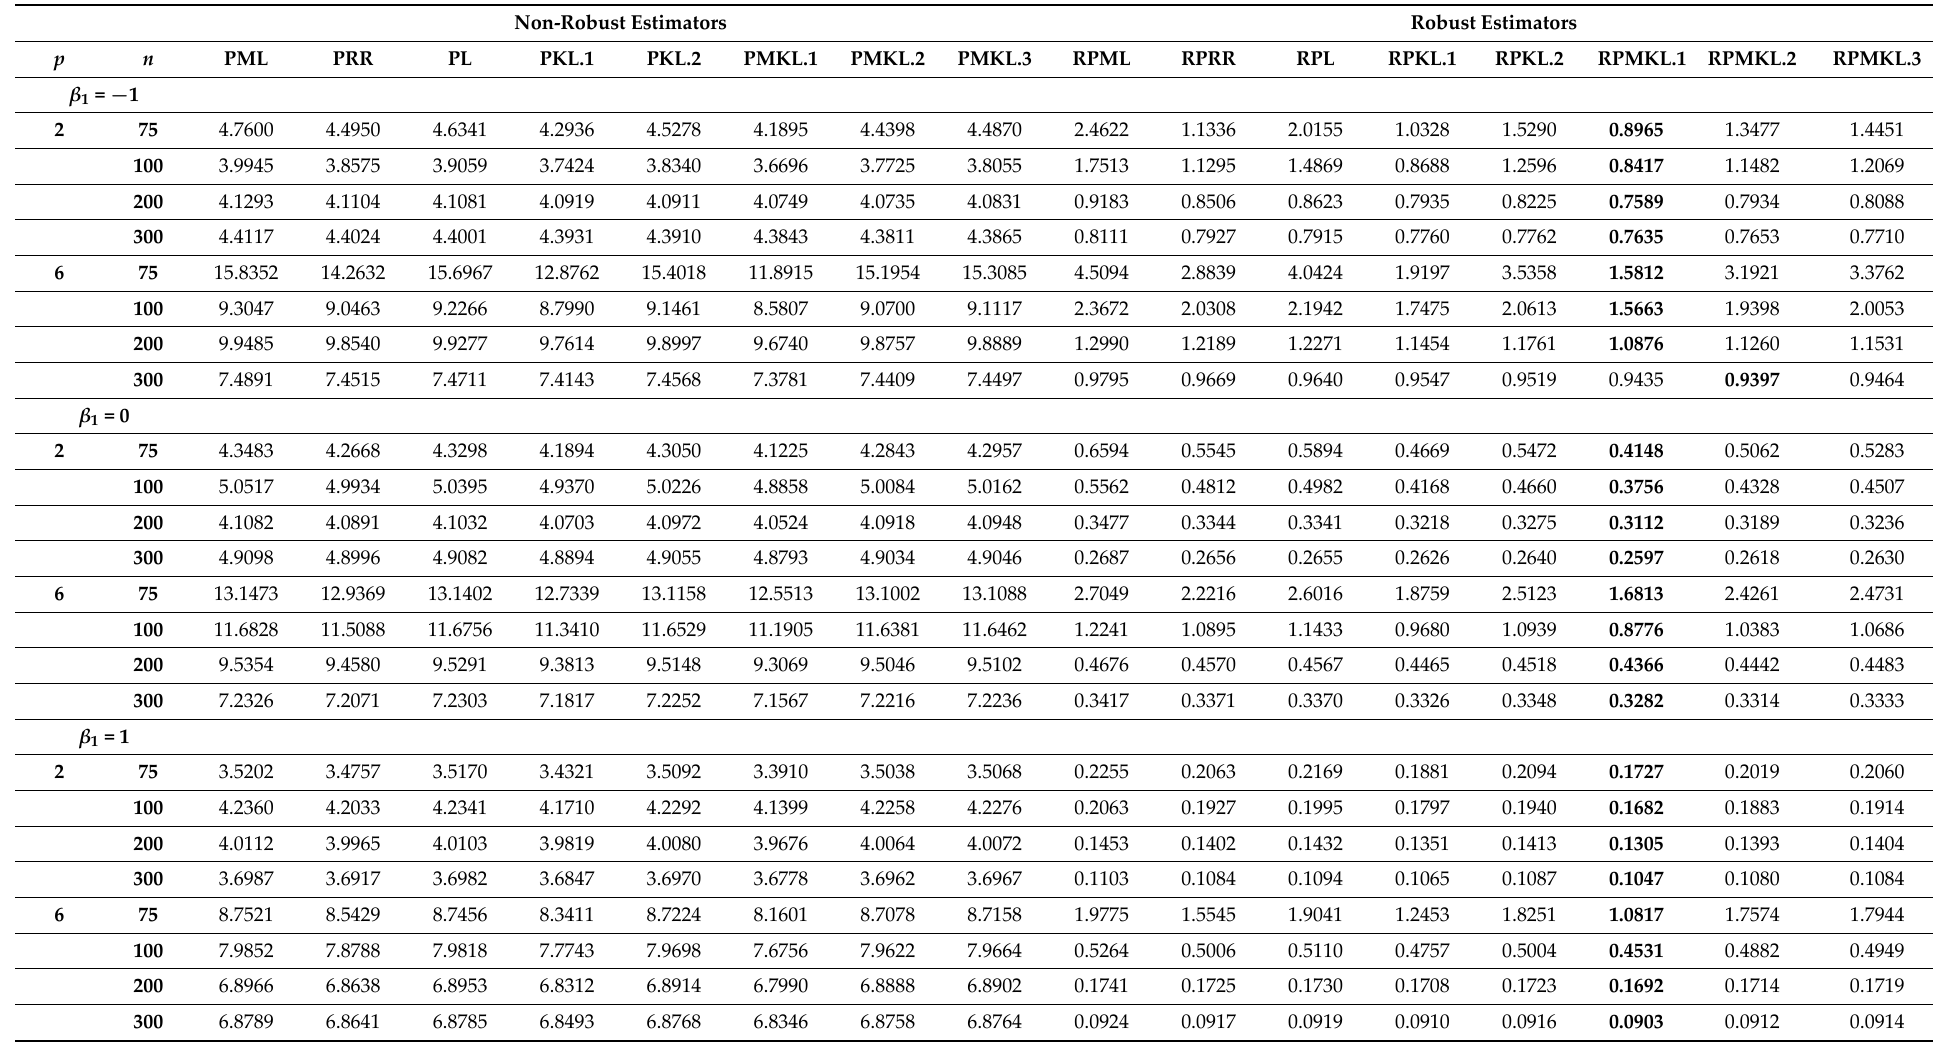
Table A8. AMSE of different estimators when τ = 20% and ρ =